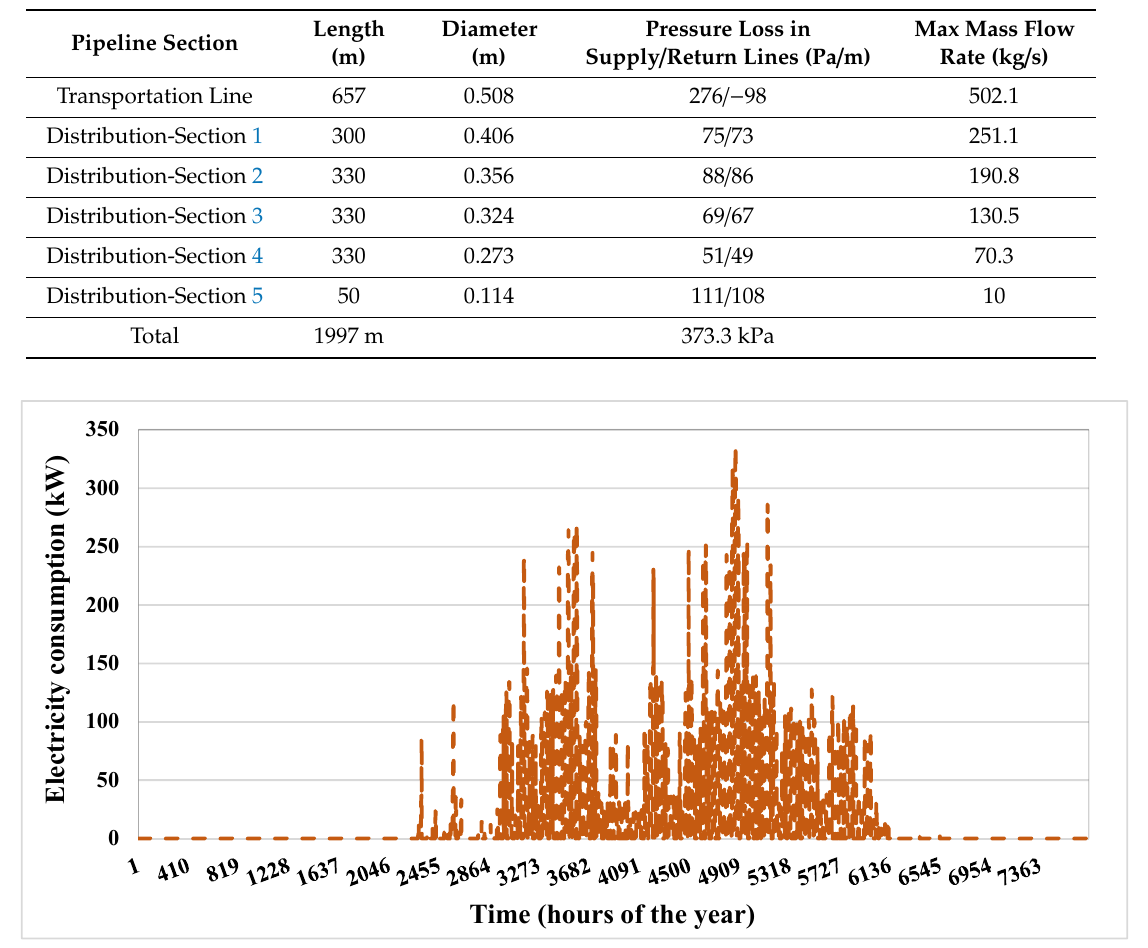
Figure 12. Rate of electricity consumption of the system over the year.